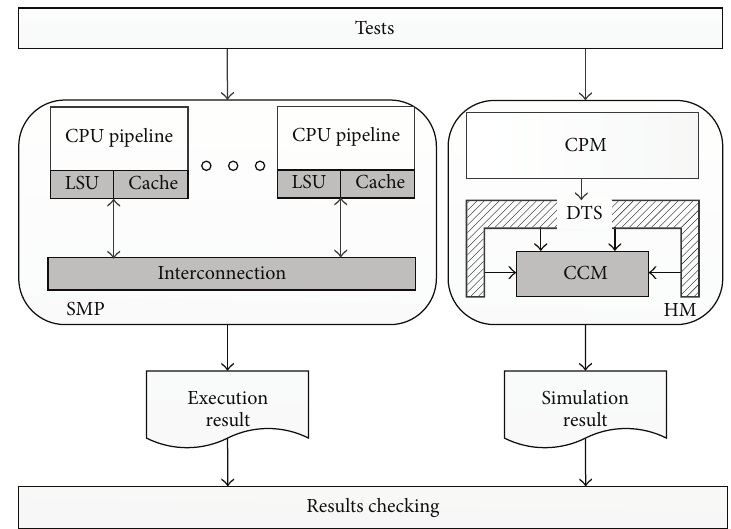
Figure 1: Efficient symmetric multiprocessor verification.